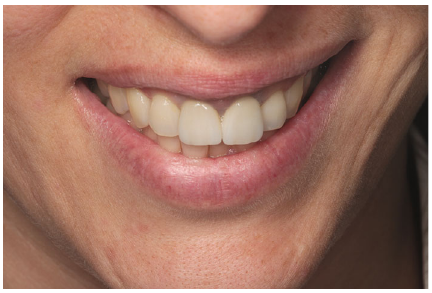
Figure 30: Extraoral view of smile after cementing the de fi nitive